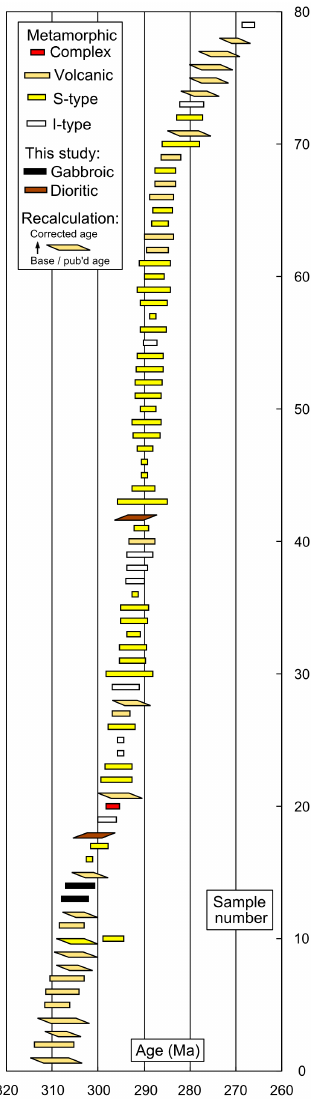
Figure 10. Summary of age determinations for latest Carbonifer- ous to early Permian magmatic rocks of the Southern NEO, corre- sponding to the first, predominantly S-type granitic magmatism in the orogen. Sources of data in Supplement S4.